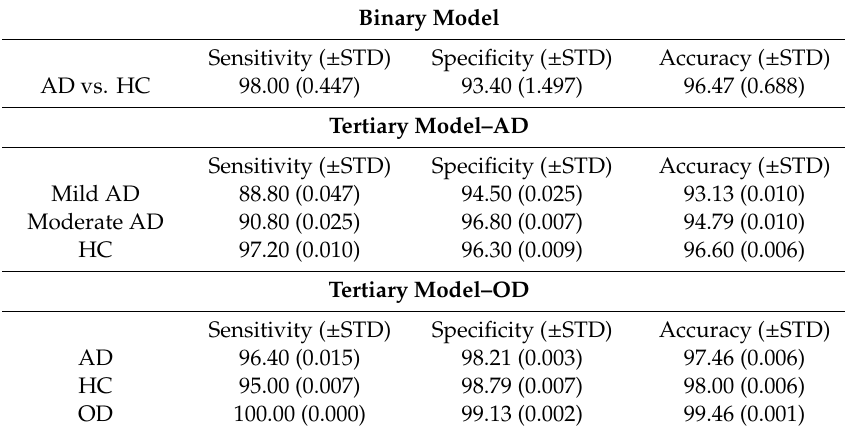
Table 5. Final network results of binary and tertiary ANN models for di ff erentiating between classes of blood serum